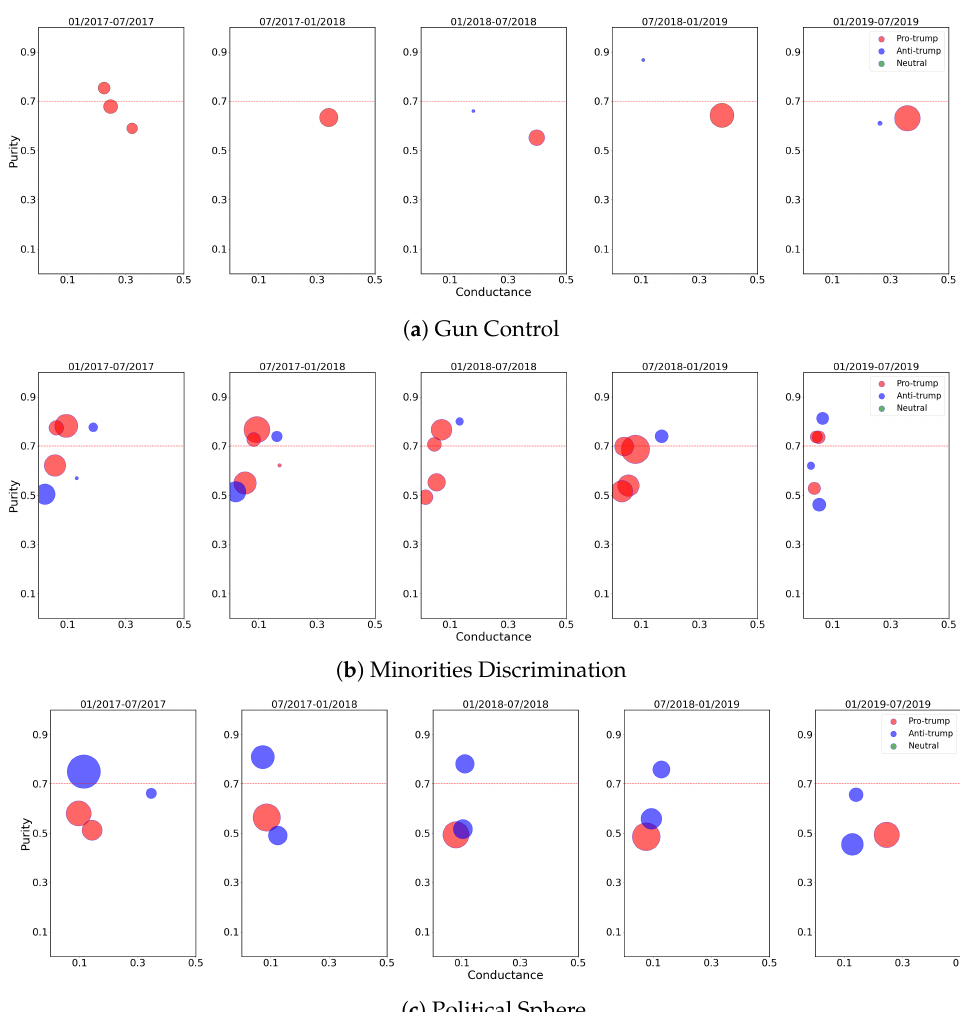
Figure 3. Communities evaluation for G UN C ONTROL ( a ), MINORITIES DISCRIMINATION ( b ), and P OLITICAL S PHERE ( c ) topics. The scatter plots display, for each semester, the Conductance ( x -axis) and Purity ( y -axis) scores for each detected community. Circles represent EVA communities, where red denotes communities populated by most Pro-Trump users, blue by Anti-Trump ones, and green Neutral. The horizontal red line marks the Purity threshold (0.7). Thus, the communities lying above it can be classified as strong echo chambers. Note that here, we are just plotting those communities that satisfy the Conductance constraint